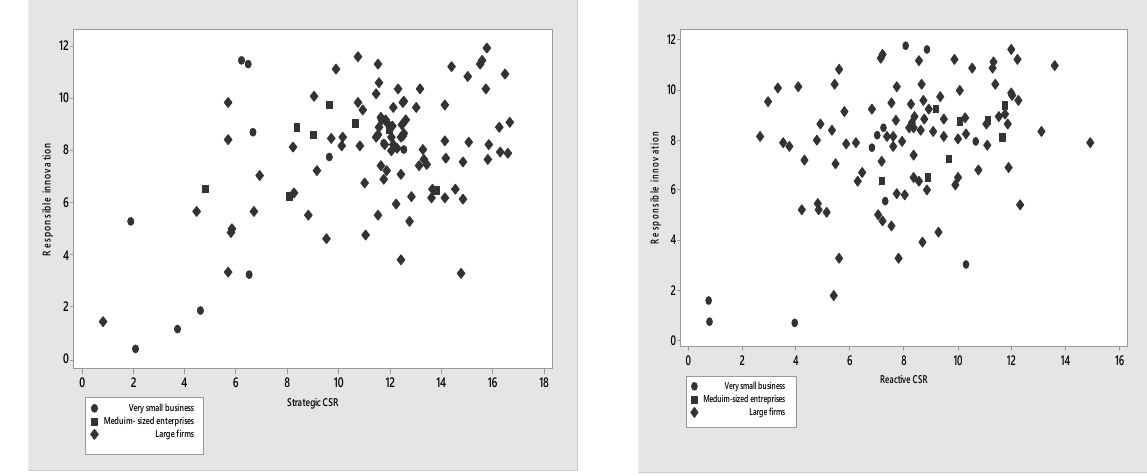
Fig. 4: Scatter plot of the variables reactive CSR, strategic CSR and competitive advantage according to the firm size As shown in Table 3, the estimations of Models 1 and 3 showed that both strategic and reactive CSR have positive and significant repercussions on responsible innovation (a 1 = 1,008 and a 1 =0.710, respectively). Our estimates of Model 6